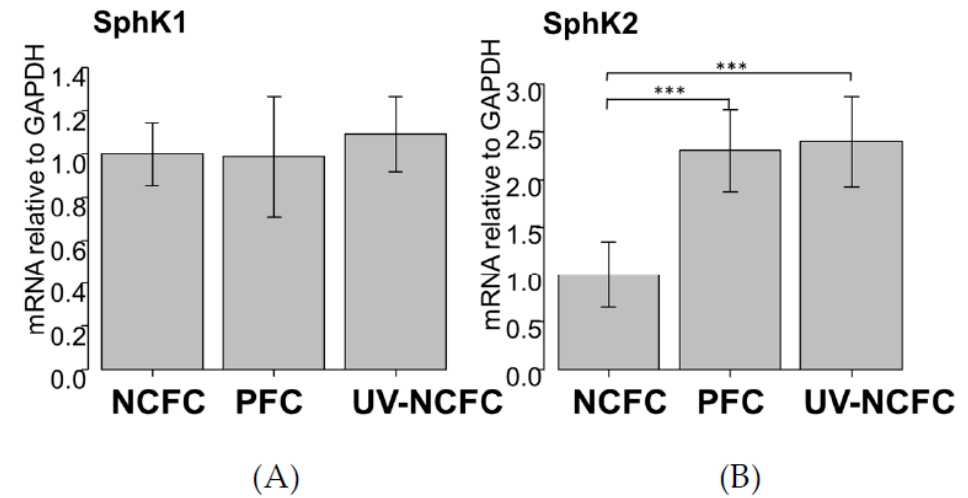
Figure 3. qPCR quantification of NCFC (normal conjunctival fibroblast cell), PFC (pterygium fibrovlast cell), and UV-NCFC (normal conjunctival fibroblast cells irradiated with ultraviolet) mRNA expression of SphK1 ( A ) and SphK2 ( B ) relative to GAPDH ( n = 4). The relative mRNA expression of SphK2 ( B ) was significantly higher in PFCs and UV-NCFCs than in normal conjunctiva tissue. *** p < 0.001.